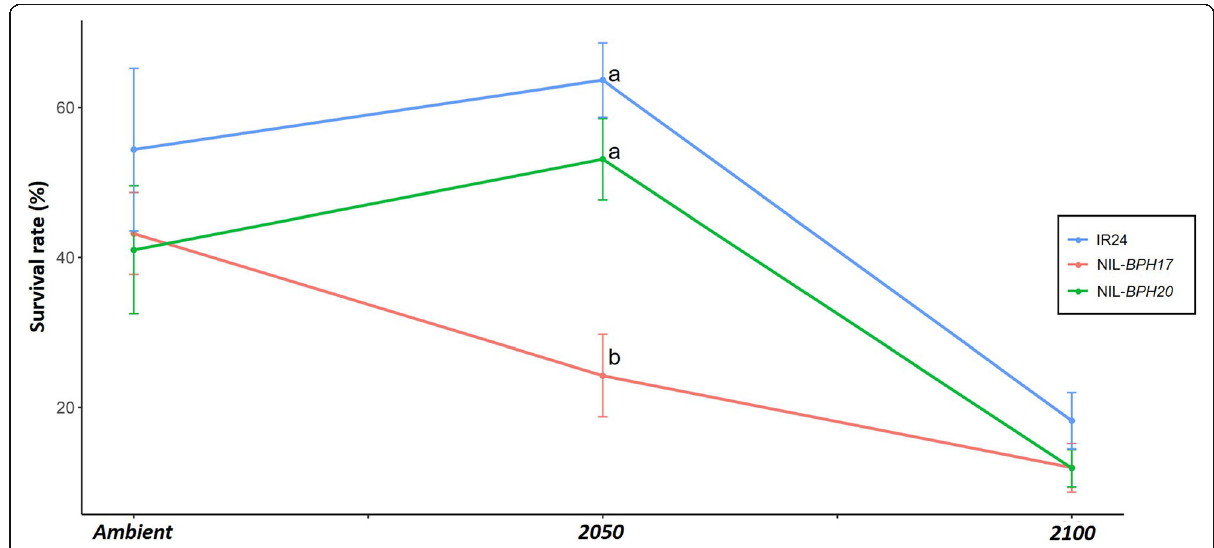
Fig. 5 The interaction plot of day 9 survival rate of N. lugens nymphs under different environments. Means in each column followed by a different letter differ significantly ( P <